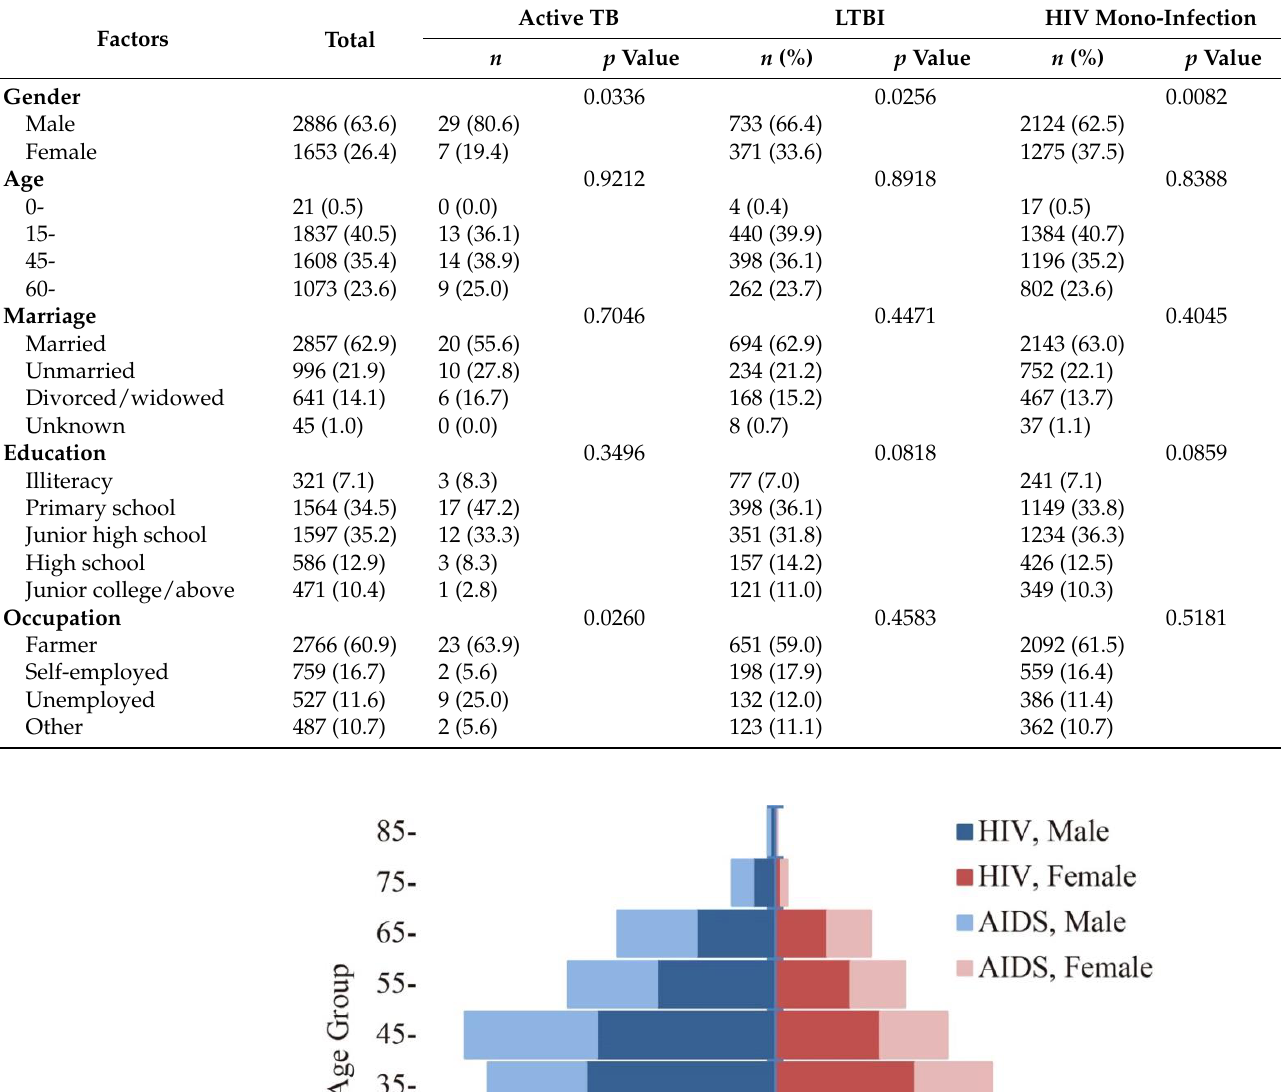
Table 2. Demographics of HIV/AIDS outpatients in Guangxi Province.